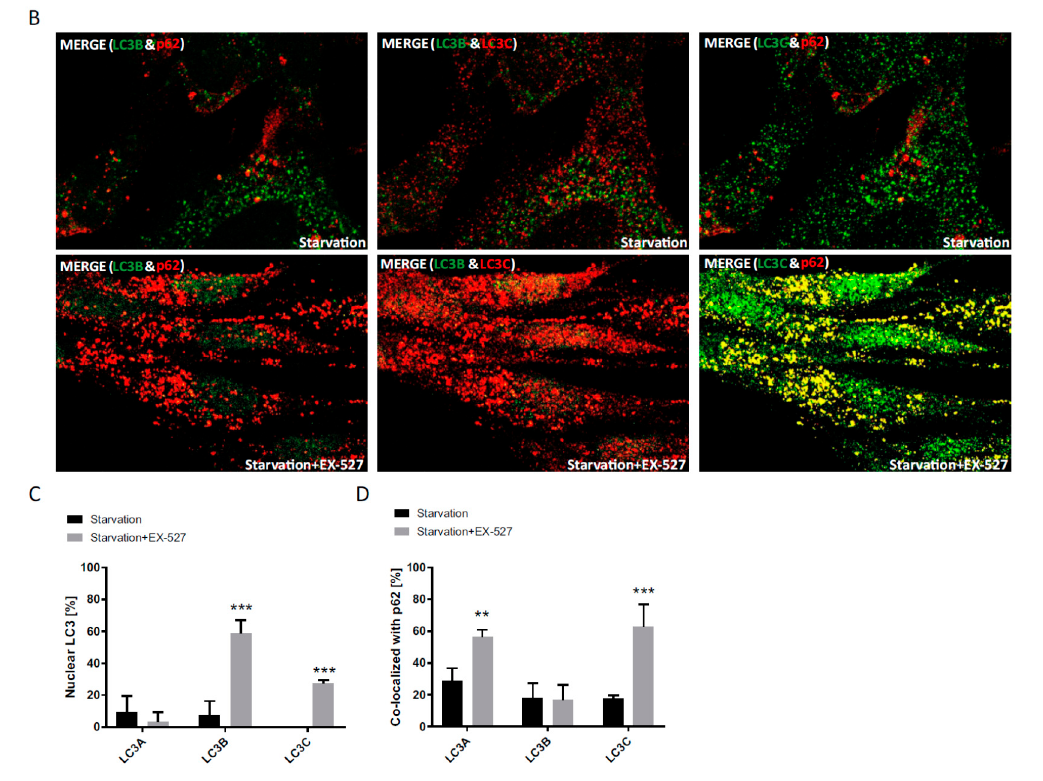
Figure 6. Analysis of the cellular localization of LC3A, LC3B and LC3C in response to pharmacological sirtuin inhibition under starvation conditions. Primary human fibroblasts were grown under starvation conditions and treated with BafA1 and Ex527. ( A ) Cellular localization of LC3A, LC3B and p62 after treatment with Ex527 and BafA1. ( B ) Cellular localization of LC3C, LC3B and p62 after treatment with Ex527 and BafA1. ( C ) Quantification of the relative nuclear fraction of LC3A, LC3B and LC3C in cells treated as indicated. ( D ) Relative co-localization of LC3C, LC3B and LC3A with p62 quantified by image analysis. Significant changes (by two-way ANOVA) versus starvation-only treated cells: ** p ≤ 0.01; *** p ≤ 0.001. Data in ( C ) and ( D ) were derived from three photographed, independent experiments ( n = 3), in which 12–45 cells per image were analyzed.